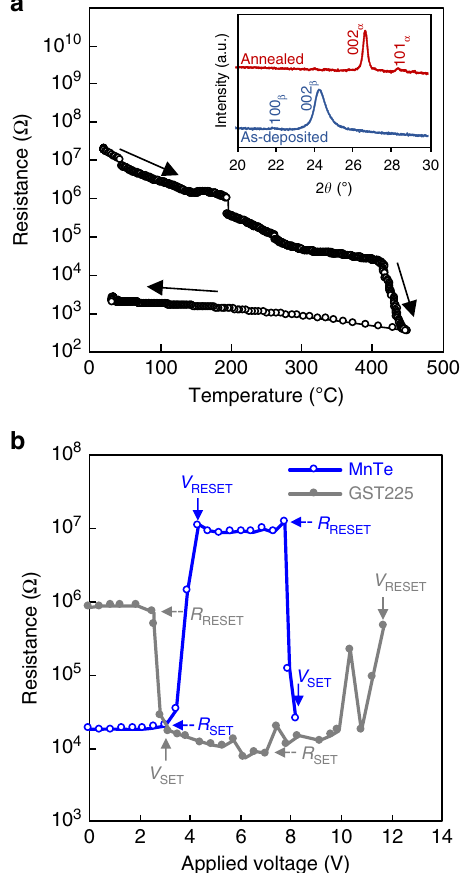
Fig. 1 Resistance change behavior upon phase change in MnTe. a Temperature dependence of resistance of the as-deposited MnTe fi lm during heating followed by cooling to RT; the step decrease in resistance at around 200 °C is due to the experimental error caused when the measuring range is switched from 10 6 to 10 5 . The inset shows X-ray diffraction (XRD) patterns at room temperature (RT) of as-deposited (blue) and 500 °C annealed (red) fi lms. b A resistance ( R ) vs. voltage ( V ) curve for MnTe (open circles) and Ge 2 Sb 2 Te 5 (GST225) devices ( fi lled circles), read voltage was 0.1 V. The as-annealed MnTe device with low resistance was used for the measurement; the GST225 device was fi rst annealed at 260 °C then cooled to RT and fi nally it was RESET-operated by applying 13.8 V for 50 ns before the measurement. Solid arrows indicate the critical voltage for RESET ( V RESET ) and SET ( V SET ) operations, and dashed arrows indicate the resistance of RESET ( R RESET ) and SET ( R SET ) states; these parameters were used for the operation energy